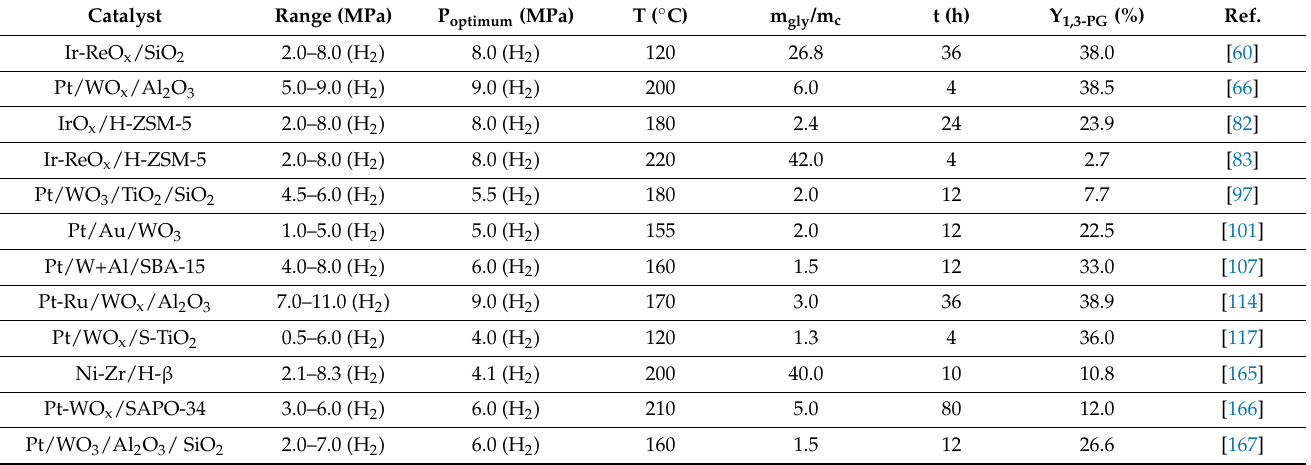
Table 11. The effect of pressure in batch reactors using different